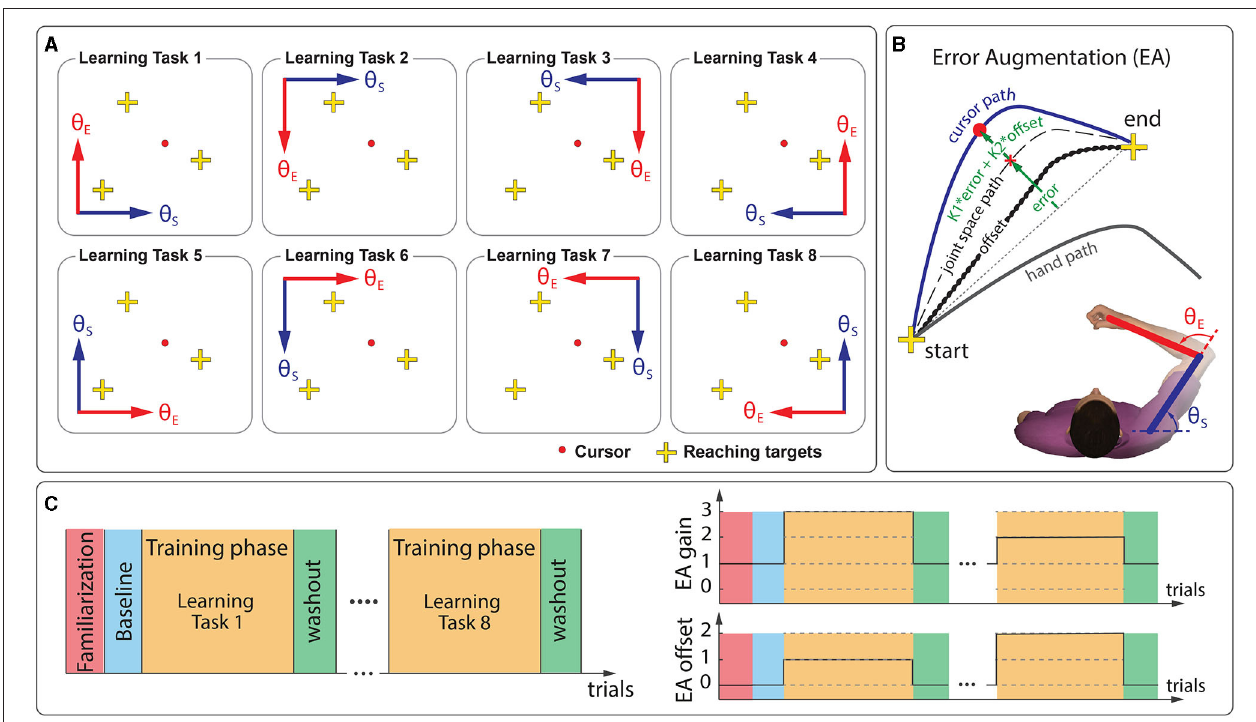
FIGURE 1 | Experimental setup. Participants reached for visual targets using a cursor by moving the handle of a manipulandum robot. (A) Their learning tasks were to adapt to various visuomotor distortions by practicing target reaching. (B) Subjects received augmented visual feedback based on error (error-augmentation or EA) during the training phases. We administered two types of EA: augmentation of the current level of error (EA-gain; K1; levels 0, 1, 2, 3) and augmentation of the = error-offset (EA-offset; K2; levels 0, 1, 2). The error-offset was the error subjects produced during initial exposure to the learning tasks. (C) The experiment consisted = of several distinct phases that included a brief familiarization phase (30 vision trials), a baseline phase (30 no-vision trials), and eight blocks of training phases (250 trials each). Each training phase was followed by a washout phase (30 vision trials). Subjects reached for visual targets at randomly chosen 6 movement directions across trials throughout the experiment. Five subjects received the normal error-feedback (EA{gain 1, offset 0}) throughout the whole experiment, and ten other subjects received randomly chosen EA{gain, offset} feedback from the given levels for each learning task (represented as dashed lines within the training